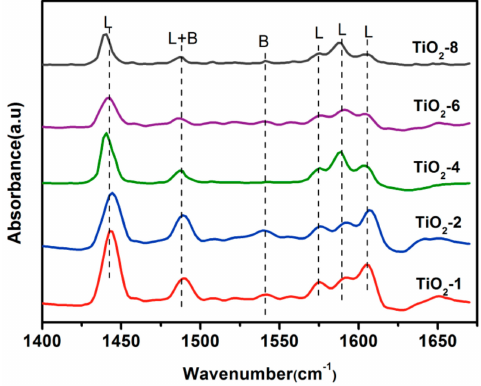
Figure 2. Py-FTIR spectra of TiO 2 prepared by di ff erent pH